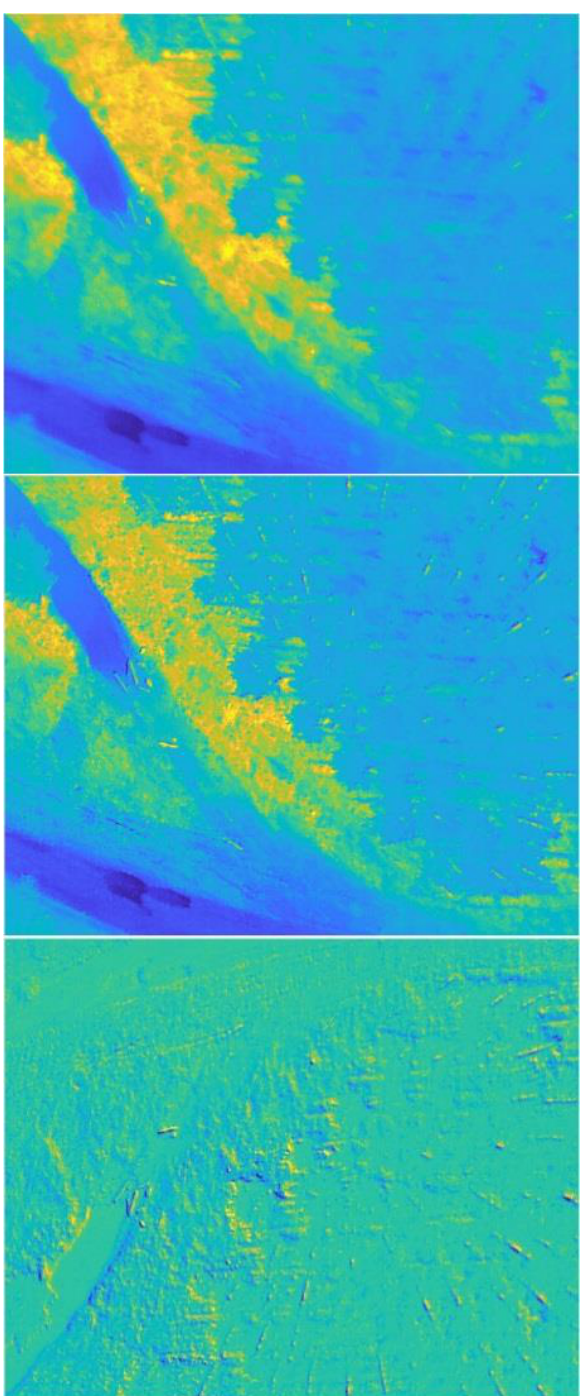
Figure 3: Example of image normalisation and edge enhancement using the BIV